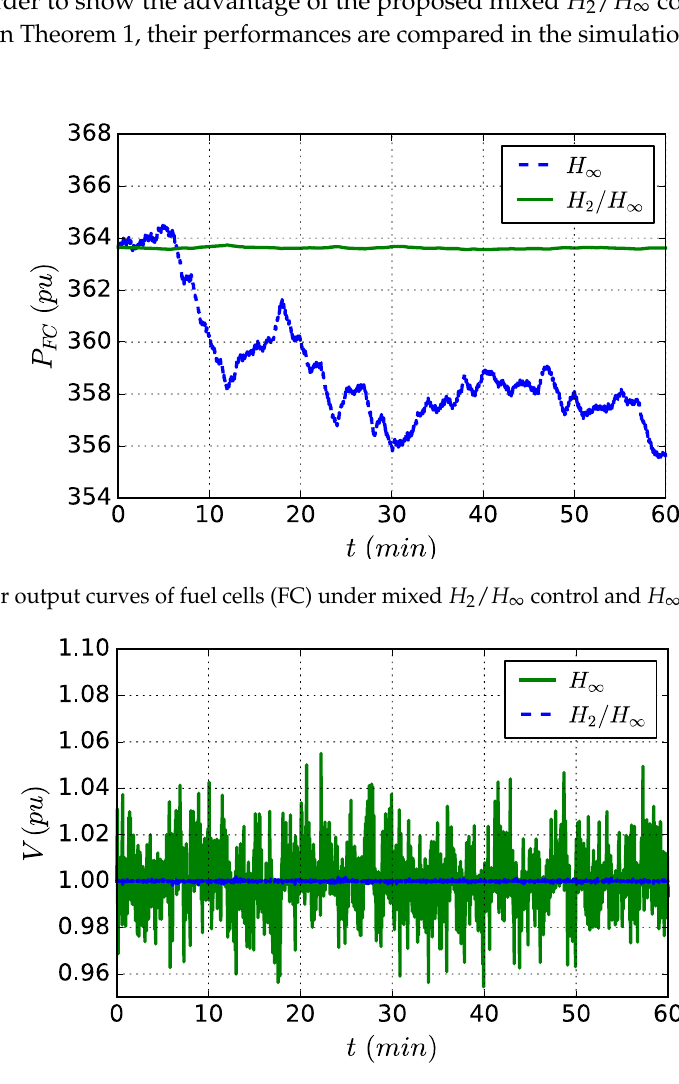
Figure 5. Voltage deviation curves under mixed H 2 / H ∞ controller and H ∞ controller.